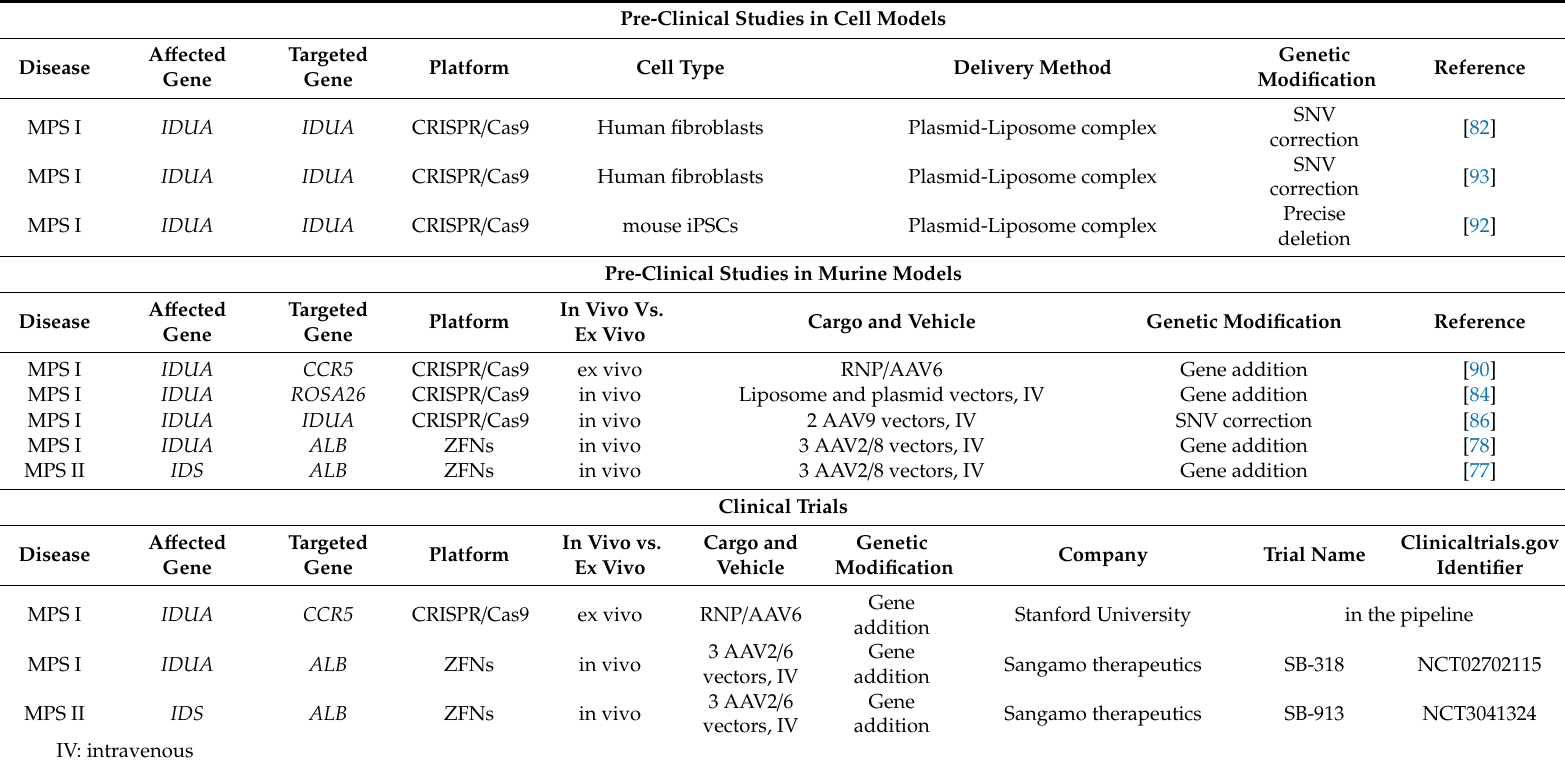
Table 1. Genome editing studies for